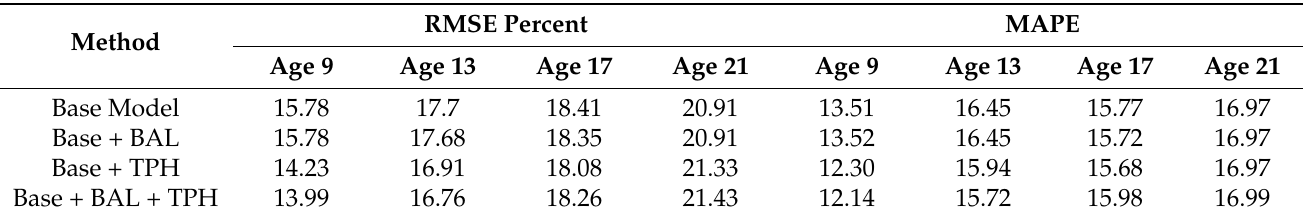
Table 6. RMSE percent and MAPE by age by incorporating additional stand-level variables (BAL and TPH) in the beta regression model.